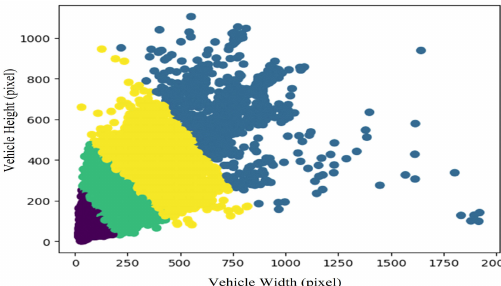
Figure 4. The clusters of four cluster points.